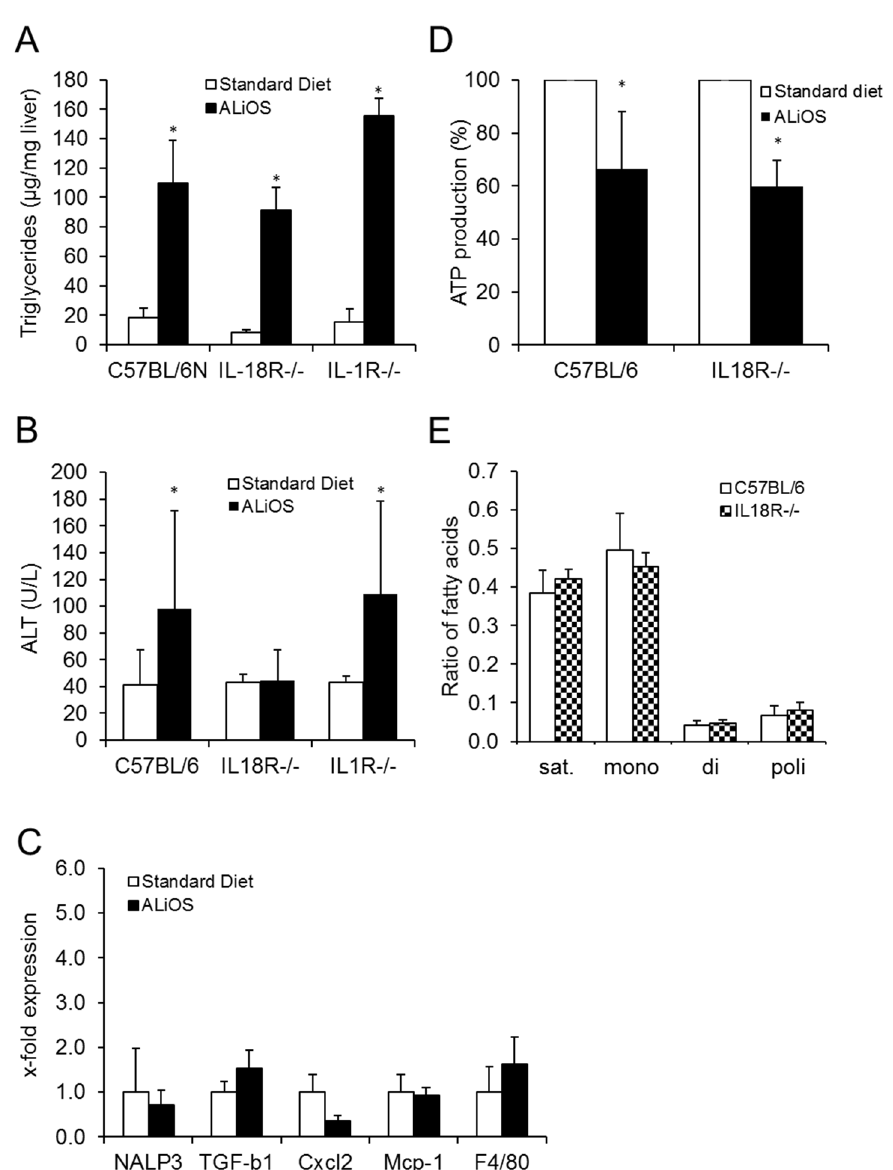
Figure 4. IL-18R- but not IL-1R-dependent signaling promotes liver damage in ALiOS diet-induced NAFLD. Mice were fed standard diet (white bars) or ALiOS diet (black bars) for 24 weeks. ( A ) Liver triglycerides ( n = 4, each; * p < 0.01; t-test) and ( B ) serum ALT levels ( n = 8–14; * p < 0.05; t-test) are shown for indicated genotypes as mean ± standard deviation. ( C ) Depiction of gene expression in liver tissue of standard diet- (white bars) and ALiOS diet-fed Il-18r − / − mice ( n = 6, each; * p < 0.01, t-test). ( D ) ATP productivity was determined in mitochondria isolated from liver tissue following 24 weeks of standard diet (white bars) and ALiOS diet (black bars) in wildtype and Il-18r − / − mice. (E) Ratios of major hepatic lipidome components (saturated, monounsaturated, diunsaturated and polyunsaturated fatty acids) in ALiOS diet-fed wildtype (black bars) and Il-18r − / − (chess field) mice ( n = 5, each, no statistical difference).